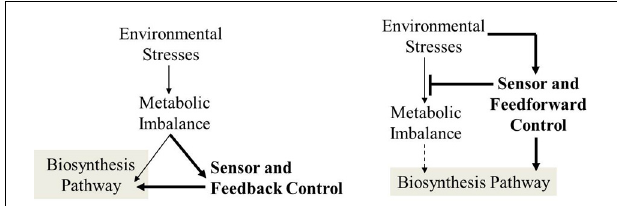
FIGURE 3 | Application of feedback and feedforward sensor-regulator systems to improve cell responses under suboptimal